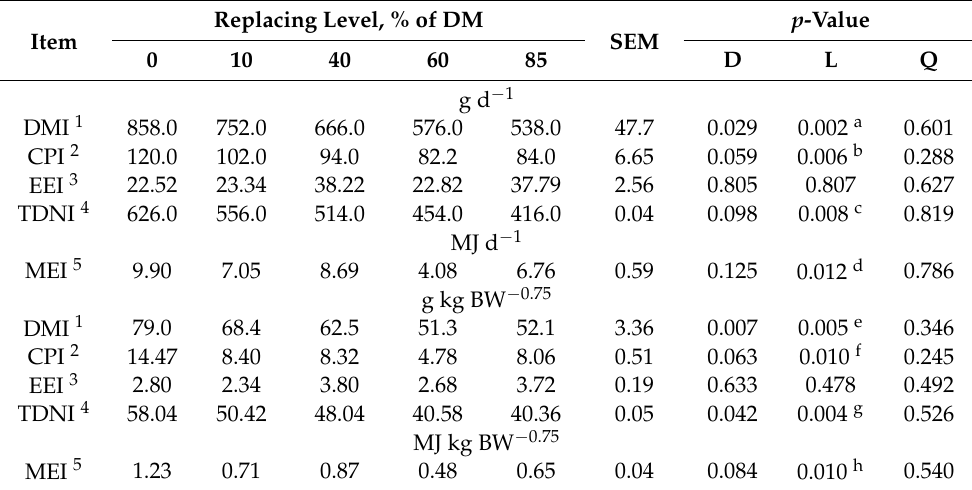
Table 2. Nutrients’ intake in lambs fed diets (D) containing peach palm meal replacing maize. Replacing Level, % of DM Item